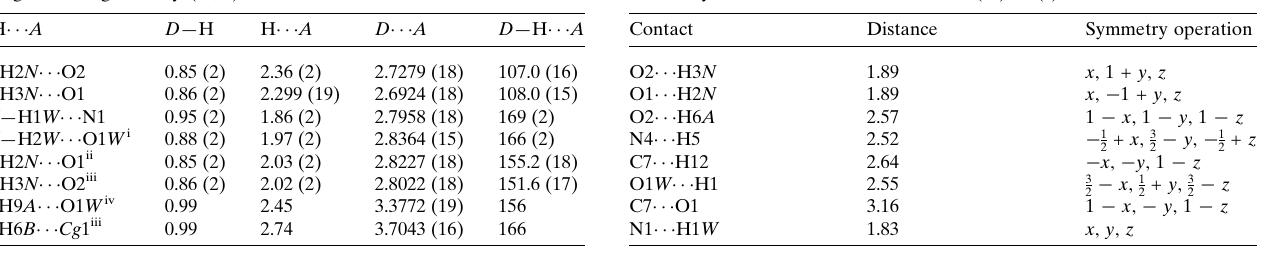
Table 2 Summary of short interatomic contacts (A˚ ) in (I) a